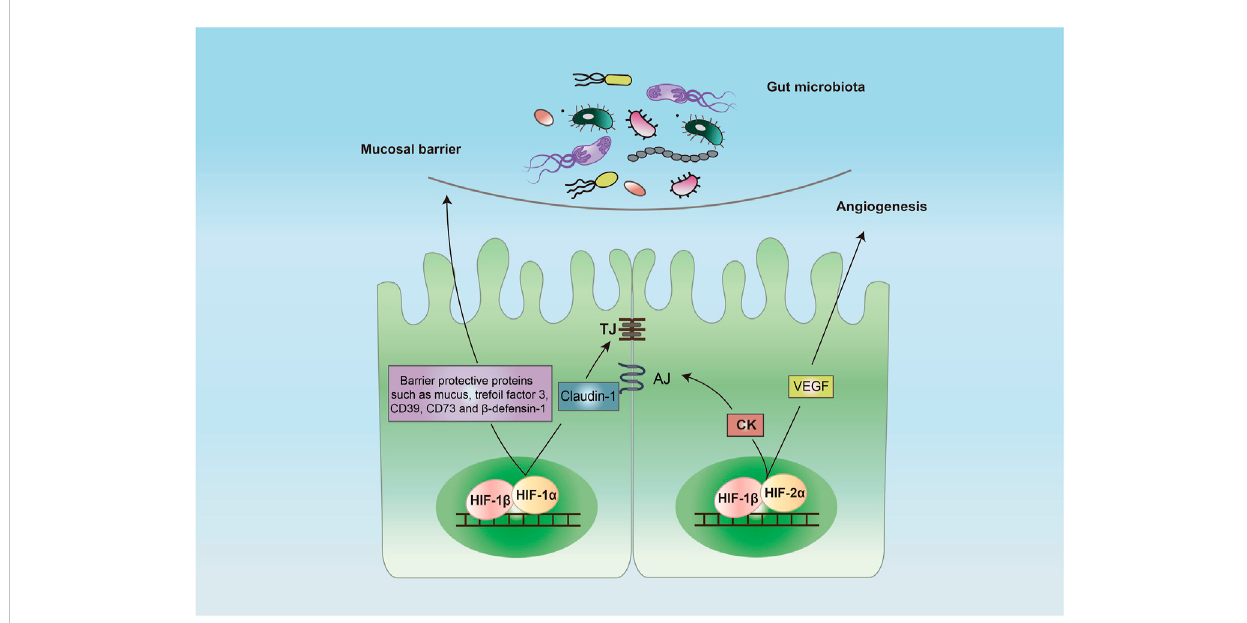
FIGURE 2 Protective role of HIF in intestinal epithelial barrier. Activation of HIF-1 in the intestine epithelial cells induces a barrier-protective pathway by increasingtheexpressionofbarrier-protectiveproteinssuchasmucus,trefoilfactor3,CD39,CD73and β -defensin-1andTJproteinclaudin-1.Activation of HIF-2 promotes the expression of CK and VEGF that promotes AJ and angiogenesis, respectively. Abbreviations: AJ, adhesion junction; CK, creatine kinase; TJ, tight junction; VEGF, vascular endothelial growth